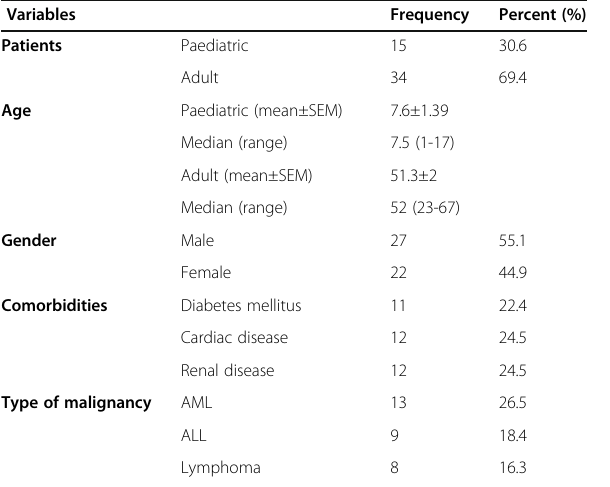
Table 1 Clinical features of the assessed COVID-19 infected cancer patients Variables